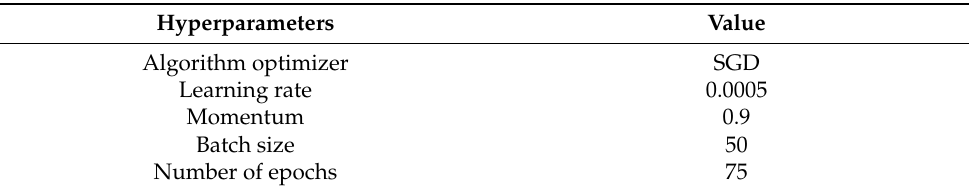
Table 2. Hyperparameters used in the training